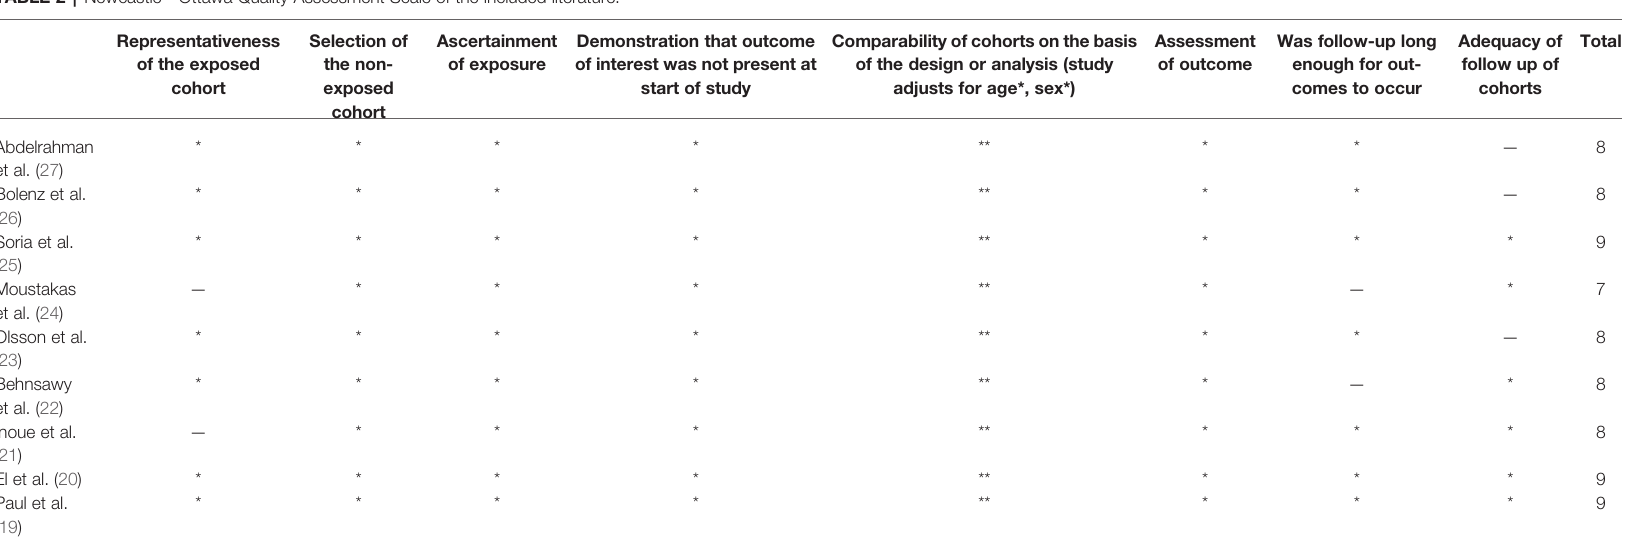
TABLE 2 | Newcastle - Ottawa Quality Assessment Scale of the included